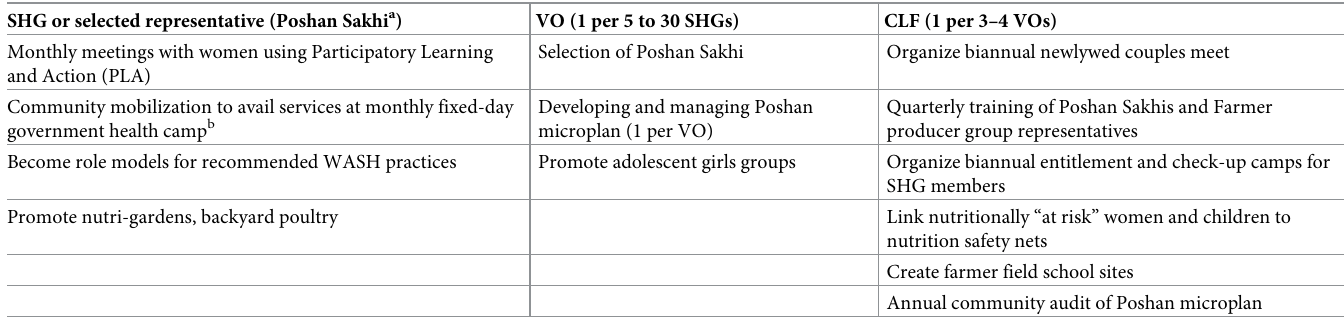
Table 1. Roles of SHGs, VOs and CLFs under